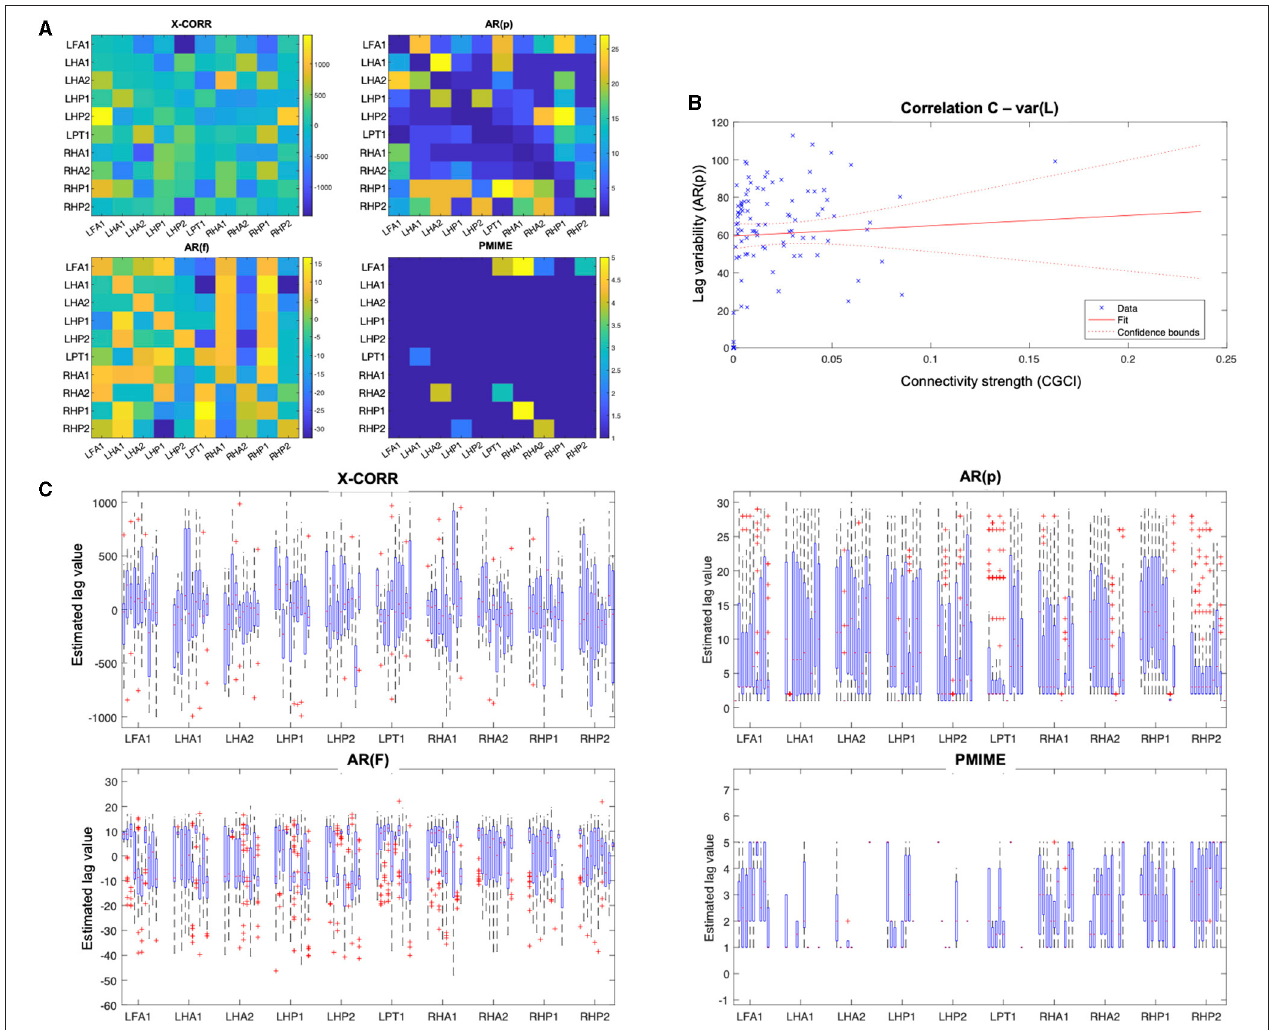
FIGURE 9 | Lag estimation results from the sEEG seizure data. (A) Lag estimation at the beginning of the seizure ( t variability during the seizure in function of the connectivity strength, as estimated by the AR(p) and CGCI measures, respectively. Each blue cross represents a data point, the red line shows a linear fitted model with the 95%-confidence bounds as dotted lines. (C) Box plot of the lag values for each channel pair, estimated during the entire